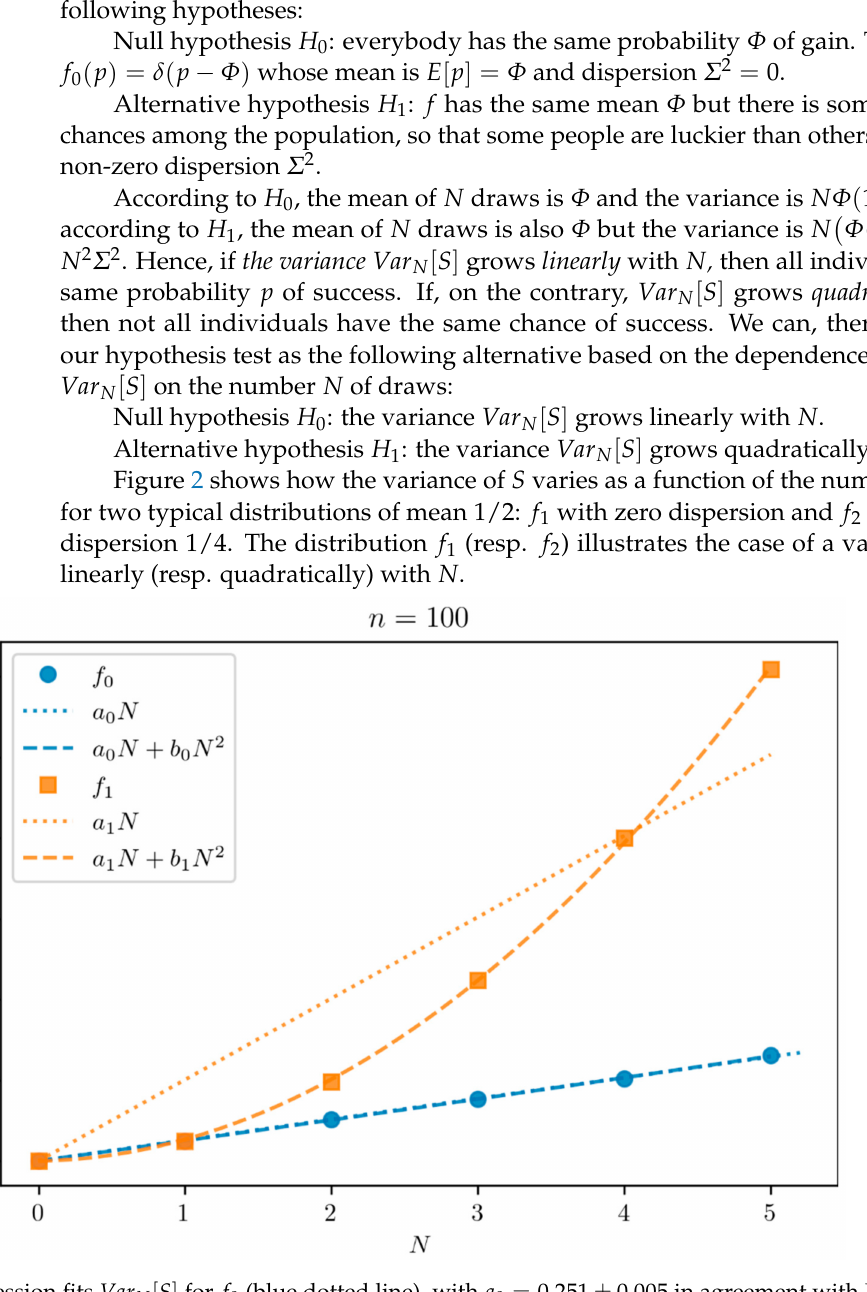
Figure 2. Linear regression fits Var N [ S ] for f 0 (blue dotted line), with a 0 = 0.251 ± 0.005 in agreement with Equation (3) when Σ 2 = 0. Moreover, a 0 agrees with the expected value Φ ( 1 − Φ ) = 1/4. The quadratic fit (blue dashed line) yields an equivalent result. At odds with f 0 , the linear regression does not fit Var N [ S ] for f 1 (orange dotted line), whereas the quadratic fit (orange dashed line) is excellent, with: a 1 = 0.01 ± 0.01 and b 1 = 0.244 ± 0.006. Here, b 1 agrees with the expected value Σ 2 = 1/4 and a 1 with the expected value Φ ( 1 − Φ ) − Σ 2 =